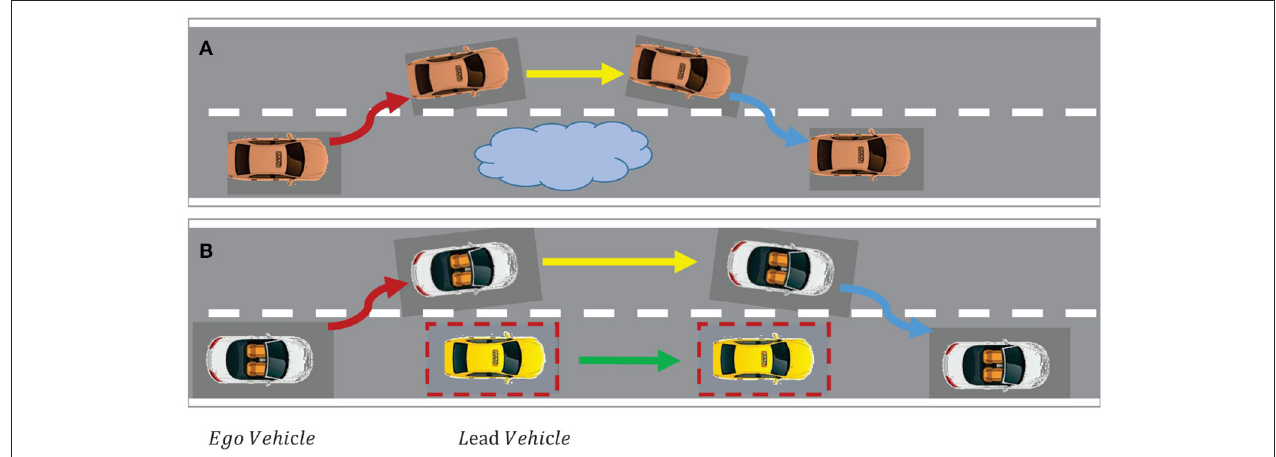
FIGURE 2 | Typical scenario of overtaking. (A) Overtaking a static object; (B) Overtaking a dynamic object.